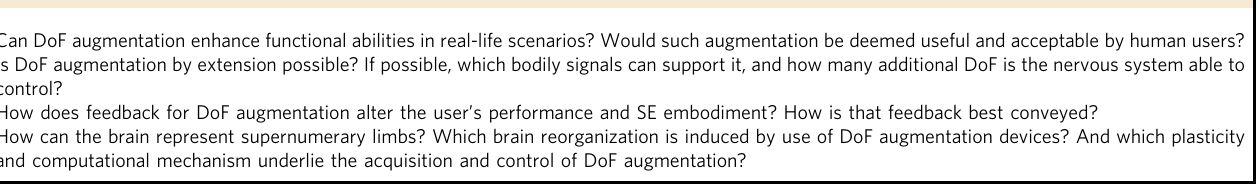
Table 3 Key open questions for DoF